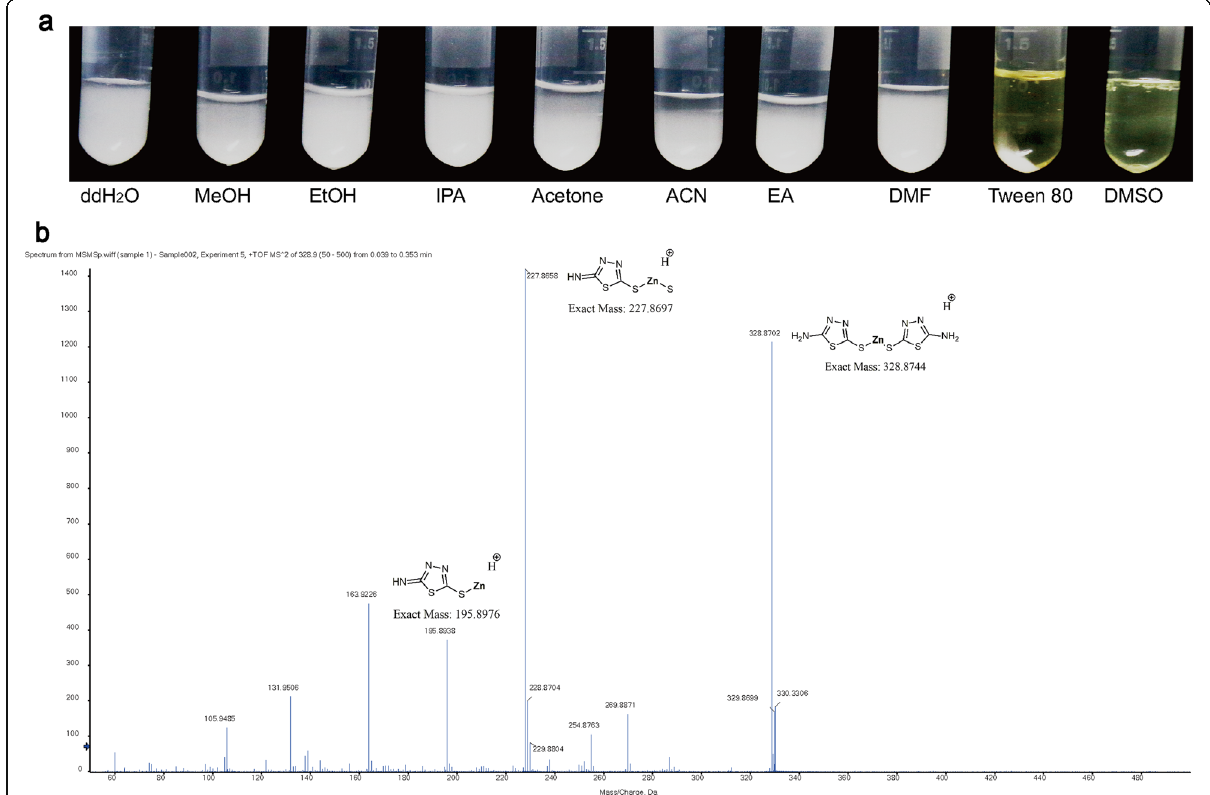
Fig. 1 Solubility and stability of zinc thiazole. a Solubility of zinc thiazole at 20 mg/mL in different solvents. b MS/MS spectrometry analyses of zinc thiazole in dimethyl sulfoxide (DMSO)